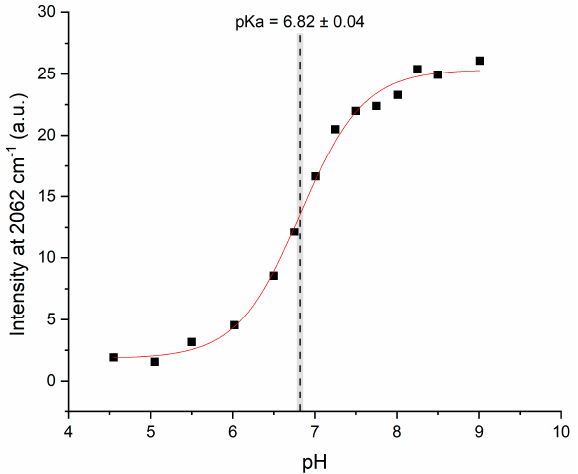
Figure 5. The intensity of the difference spectra at 2362 cm − 1 for each titration point vs pH, fitted to a